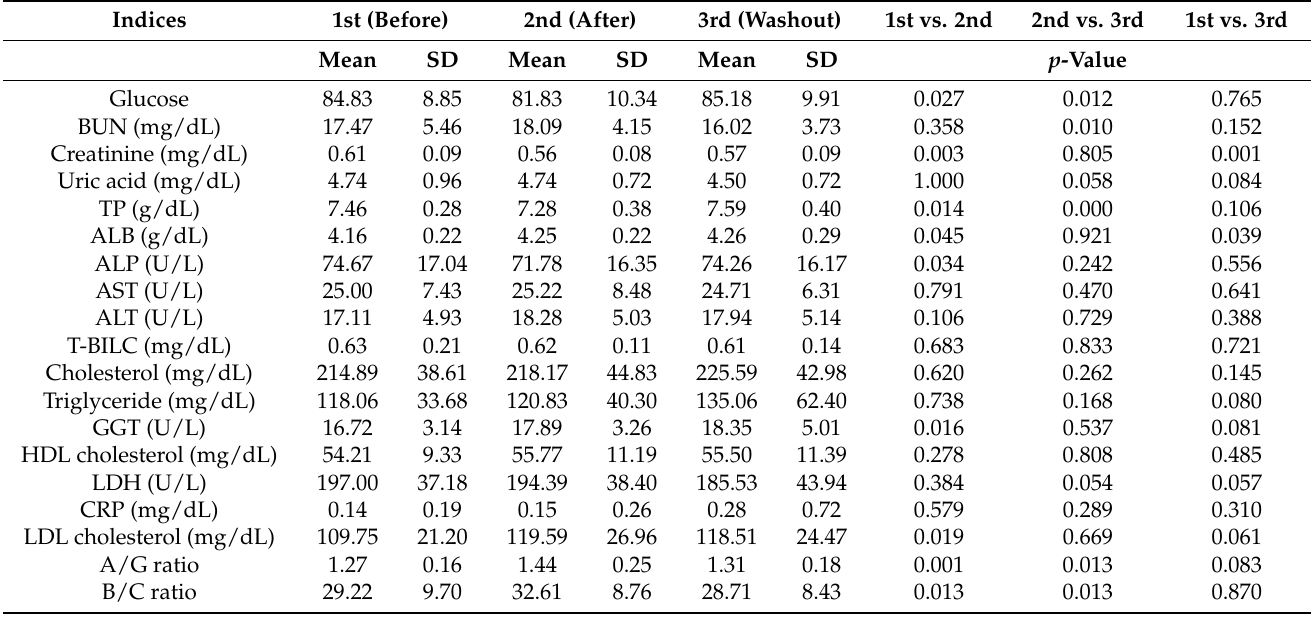
Table 2. Changes in chemical blood parameters at each time point of study